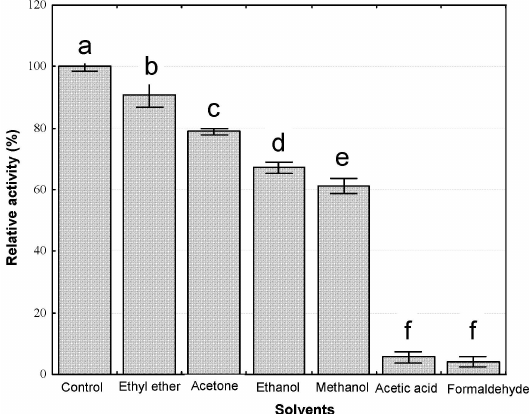
Figure 5. Solvent effect on the activity of the purified protease from Bacillus sp. P45. Bars are the means ± standard deviations of three independent experiments. The statistical analysis was performed through ANOVA, followed by Tukey’s test. Equal lowercase letters represent no significant differences at the 5%